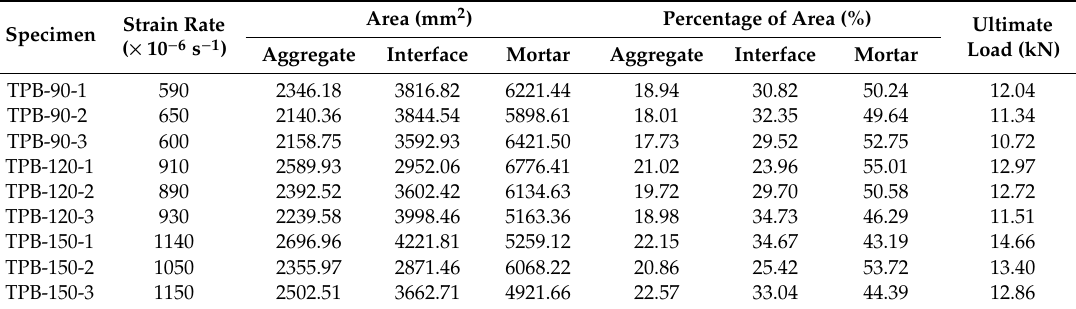
Table 4. Area percentage and ultimate loads under different strain rates.